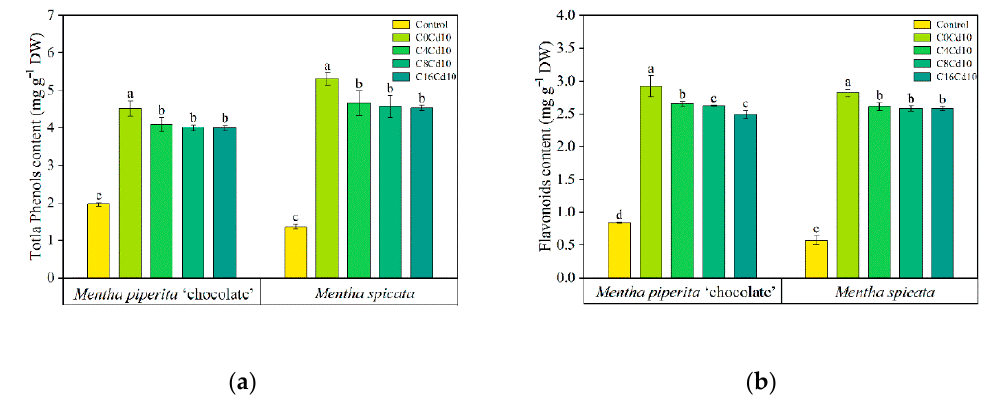
Figure 4. Effect of biochar on total phenols ( a ) and flavonoids ( b ) contents of two mint species under Cd stress. Error lines are standard deviations from the mean (n = 3), different letters indicate significantly different values between treatments for the same plant, p < 0.05. DW, dry weight.